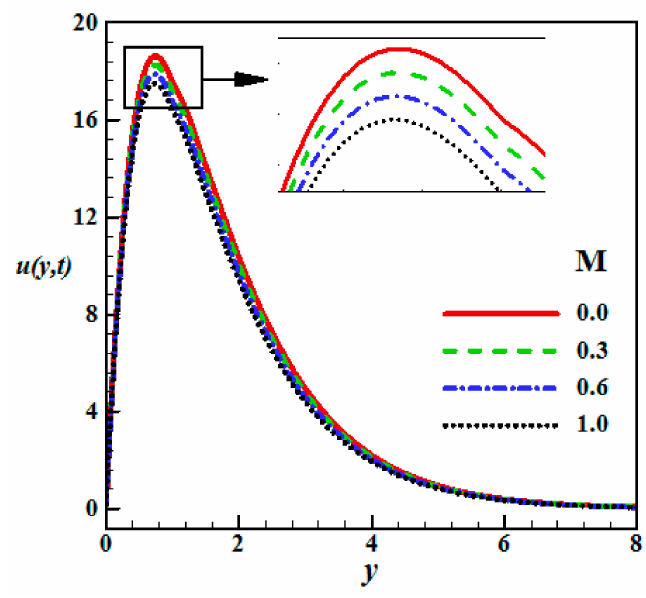
Figure 6. Impact of the magnetic parameter (M) on the velocity of the liquid.